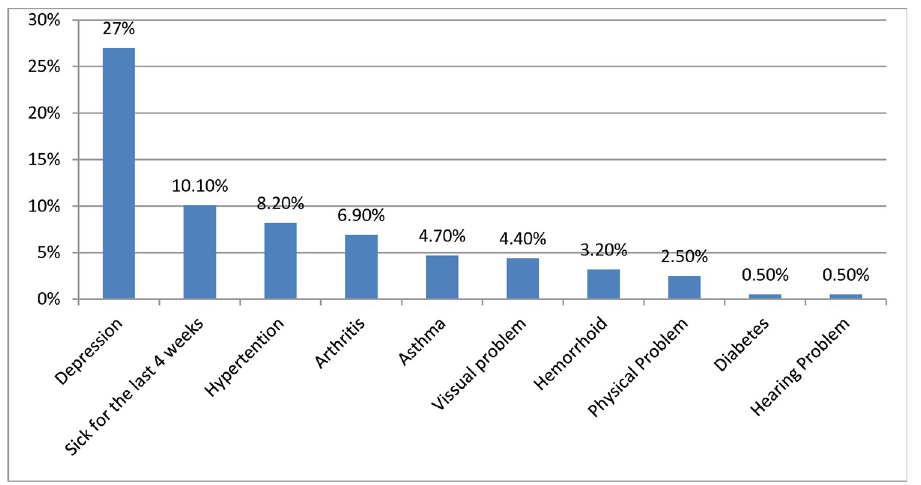
Fig 3. Health-related characteristics with undernutrition among older adults in Womberma district, North West Ethiopia, 2020 (n-594).